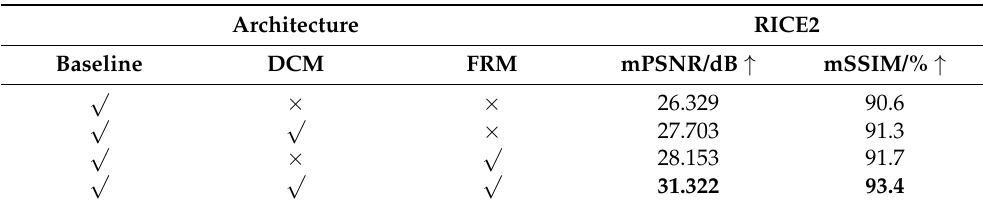
↑ : The higher score indicates the better effect. The best value of each indicator is highlighted in